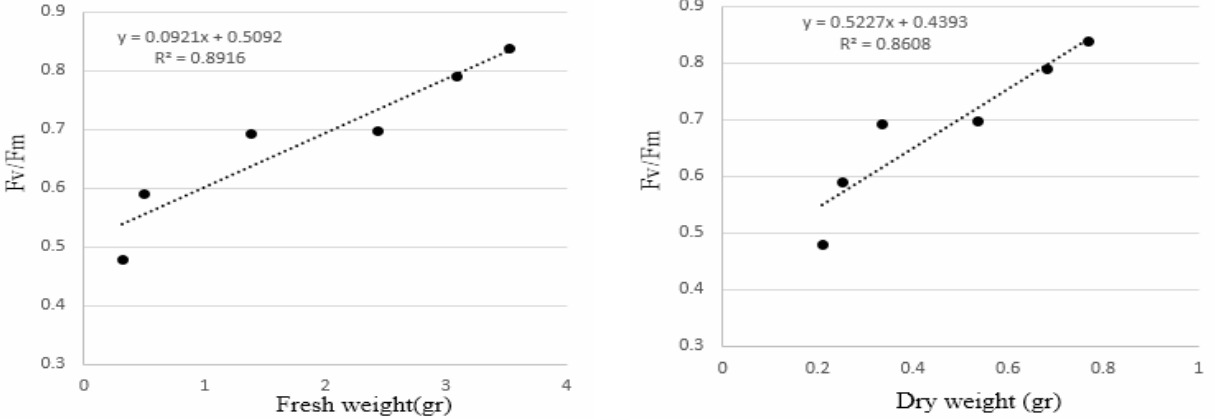
Fig. 6. Relationship between Fv/Fm parameter and fresh and dry weight at 7 days after spraying on sethoxydim plus emulsifiable turnip